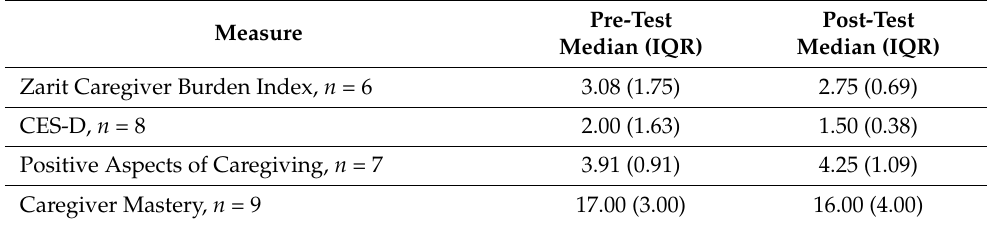
Table 3. Measures Assessed Before and After Savvy Caregiver Program (Matched).